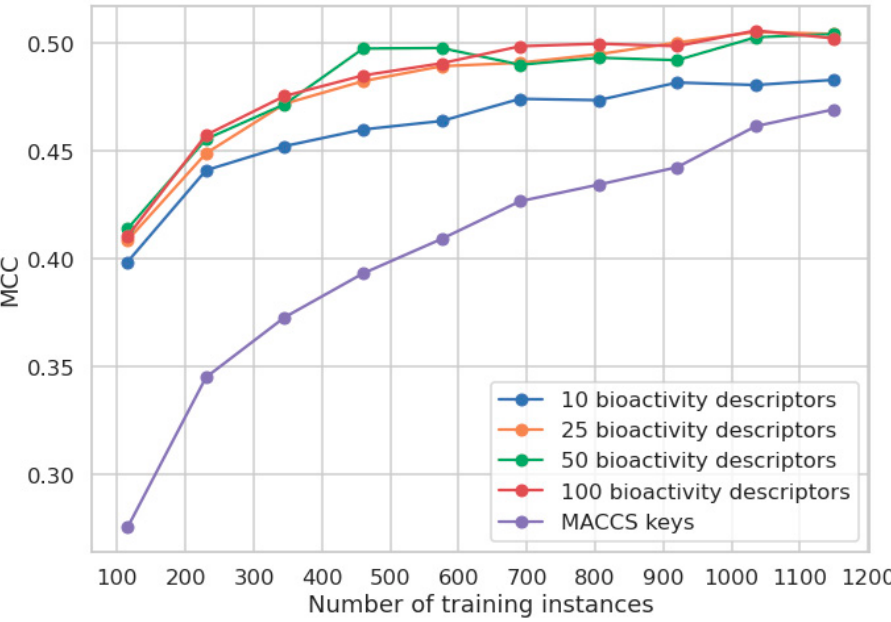
Figure 7. Performance of the RF classifier (n_estimators = 500; all other parameters default) underly- ing the CP model as a function of the number of instances the model was trained on. The MCC of the model based on MACCS keys improves from 0.28 (when trained on 115 compounds) to 0.47 (when trained on 1150 compounds), indicating that the